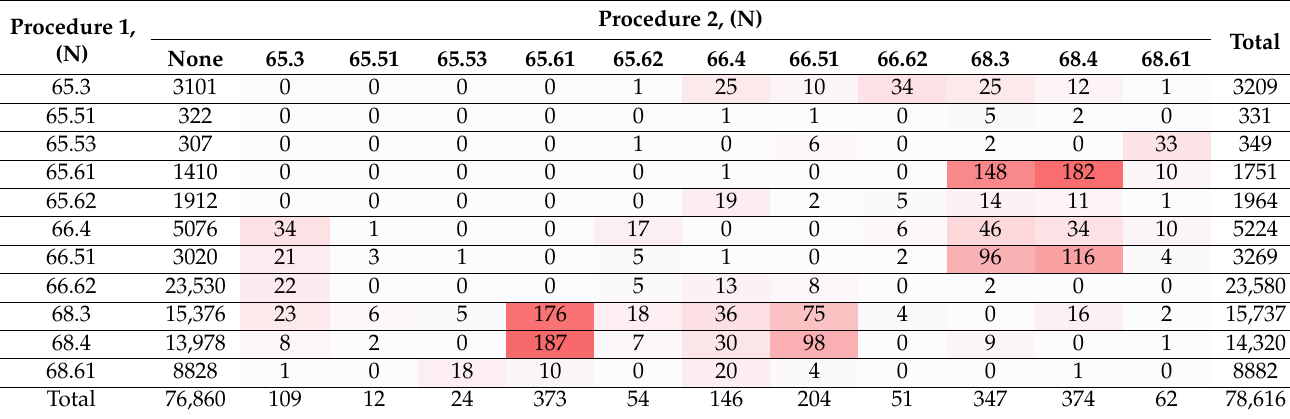
Table 1. Simultaneous surgical procedures